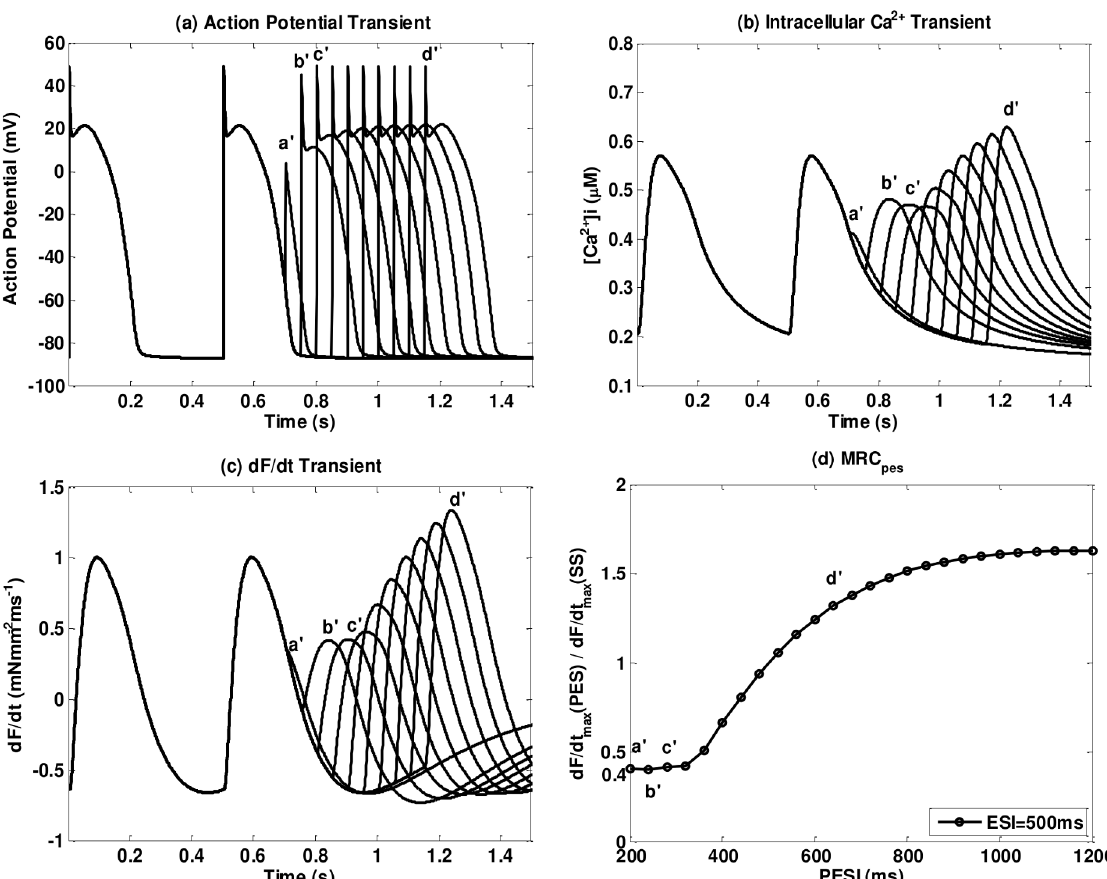
Fig 7. Details for cases where C 0 does not go to zero. We use as example the Mahajan_etal_2008 for ESI = 500ms: (a) the action potential (AP), (b) [ Ca 2+ ] i transient; (c) normalized dF / dt transient (d) normalized dF / dt max of the PES beats. In (a) (b) and (c), the first beat is the priming beat; the second beat is the ES beat with ESI = 500ms; from a ' to d' are PES beats with PESI ranges from 200ms to